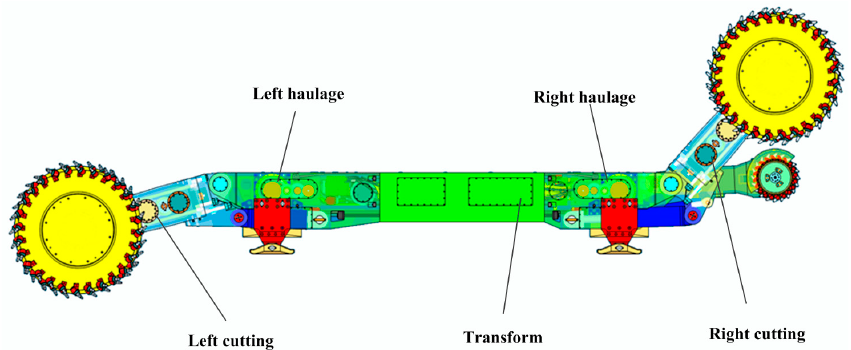
Figure 4. Structure of the shearer.